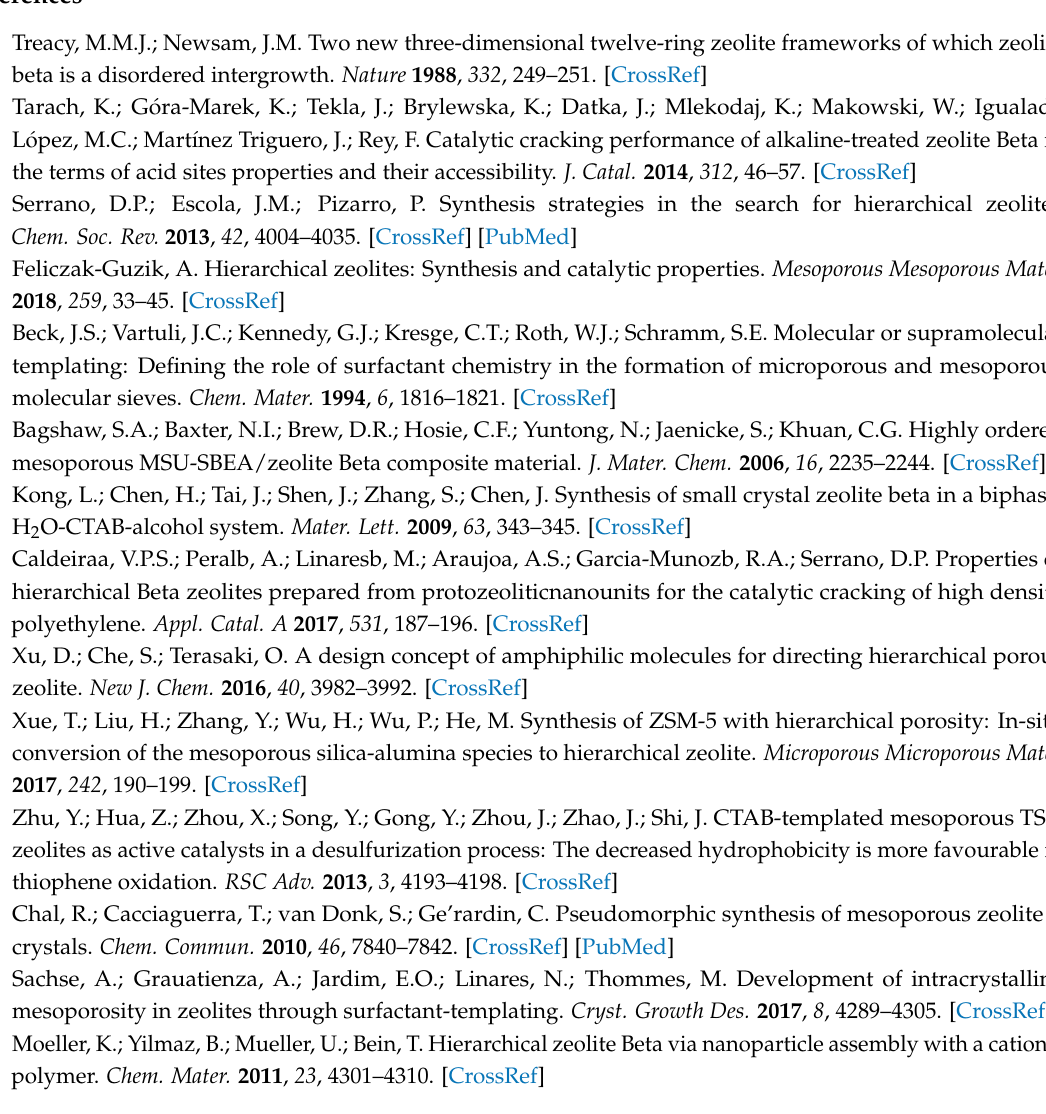
s1, Figure S1: XRD patterns of as-synthesized zeolite Beta samples with different H 2 O amount, Figure S2: N 2 adsorption-desorption isotherms of synthesized zeolite Beta samples with different H 2 O amount (left) and pore distribution (right), Figure S3: SEM images of synthesized zeolite Beta samples with different H 2 O amount, Figure S4: XRD patterns of synthesized zeolite Beta samples with different pre-crystallization time, Figure S5: SEM images of synthesized zeolite Beta samples with different pre-crystallization time, Figure S6: XRD patterns of synthesized zeolite Beta samples with alcohol, Figure S7: N 2 adsorption-desorption isotherms of synthesized zeolite Beta samples with alcohol (left) and pore distribution (right), Figure S8: Si MAS NMR spectra of microzeolite Beta MZB-1 and hierarchical zeolite Beta MZB-9, Table S1: Pore structure parameters of hierarchical Beta zeolites with 10L